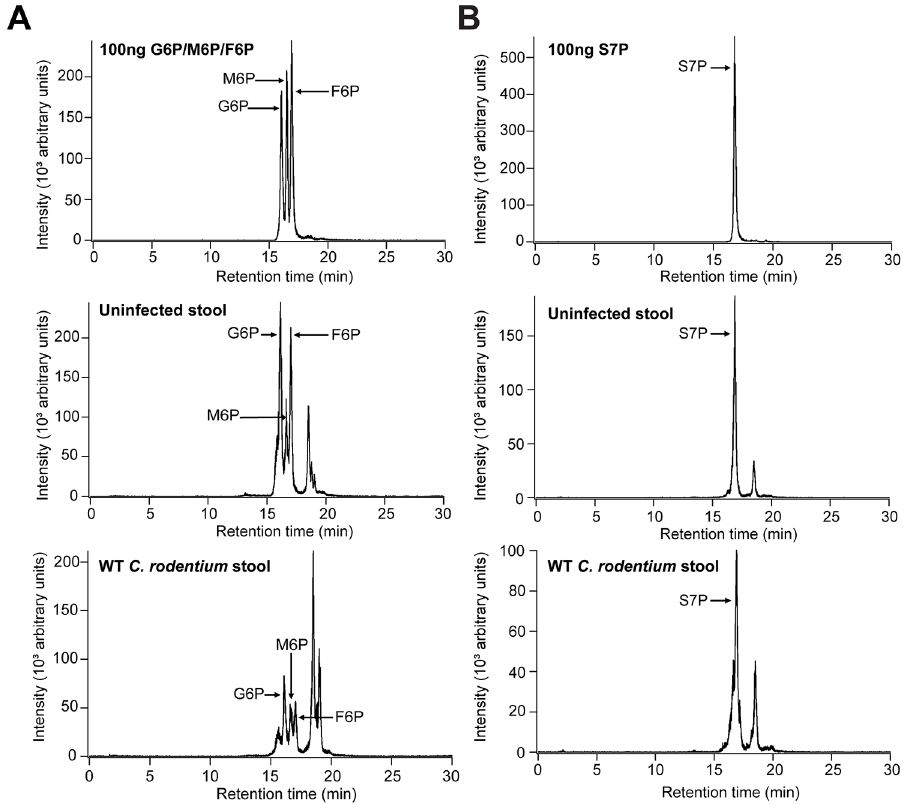
Fig 6. AfuABC substrates are present in the intestine during C . rodentium infection. (A) Representative LC-MS/MS chromatograms with indicated peaks for 100ng G6P/F6P/M6P mix (top), uninfected stool (middle) and C . rodentium WT infected stool (bottom). (B) S7P peaks. G6P/F6P/M6P were identified with a 259 ! 97 ion transition and S7P was identified with a 289 ! 97 ion